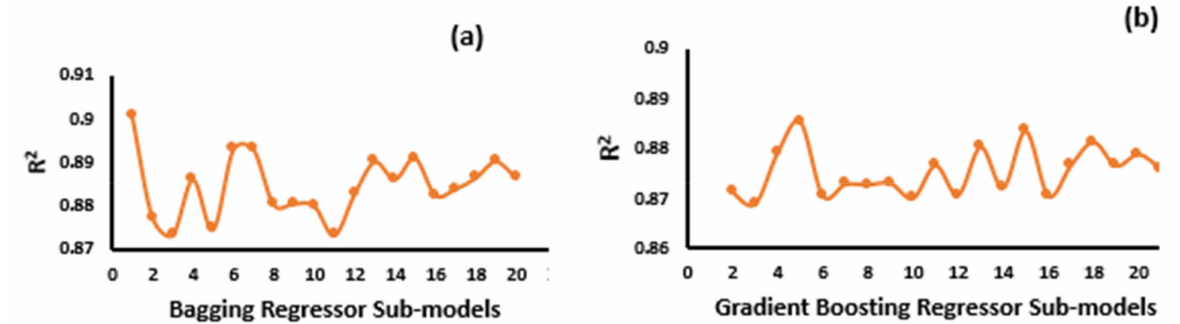
Figure 6. Sub-models representing the correlation coefficient (R 2 ) values. Bagging ( a ); GB ( b